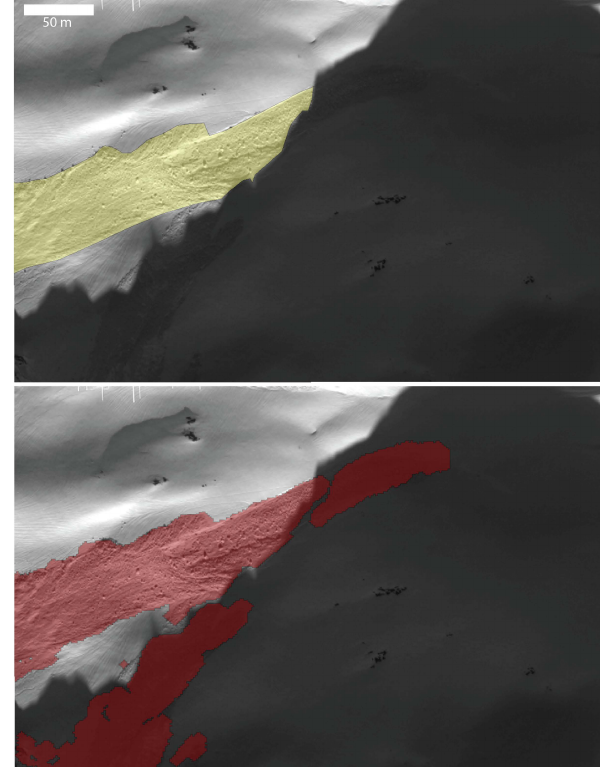
Fig. 10. QuickBird imagery over the Dalsfjord region. Image (a) (above) illustrates manual mapping of fresh snow avalanches in ArcGIS, while image (b) (below) is processed automatically in